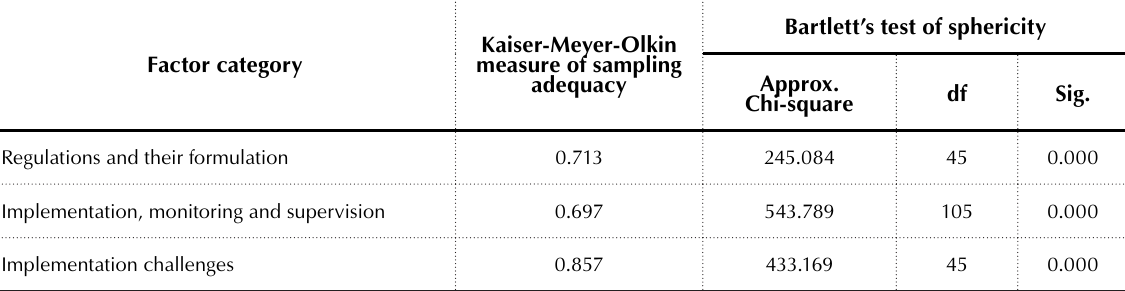
Table 1. KMO and Bartlett’s